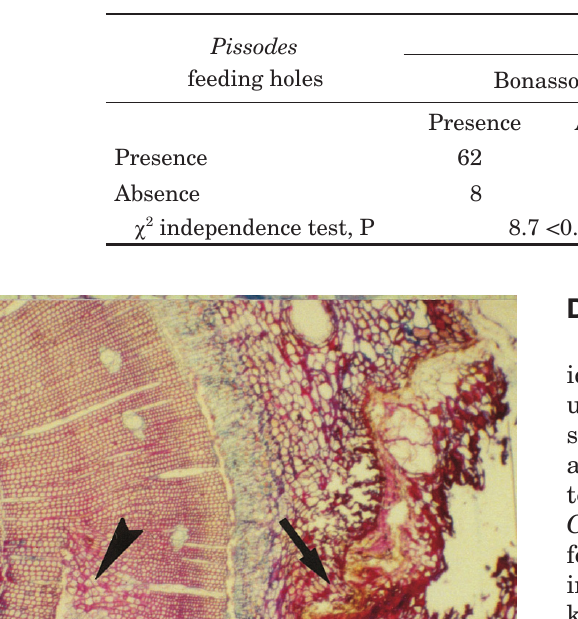
Table 1. Association between insect damage (feeding holes of Pissodes castaneus ) and knots on branches of Pinus halepensis randomly sampled at the sampling sites of Bonassola and Lerici. A total of 100 branches from 10 trees were inspected at each